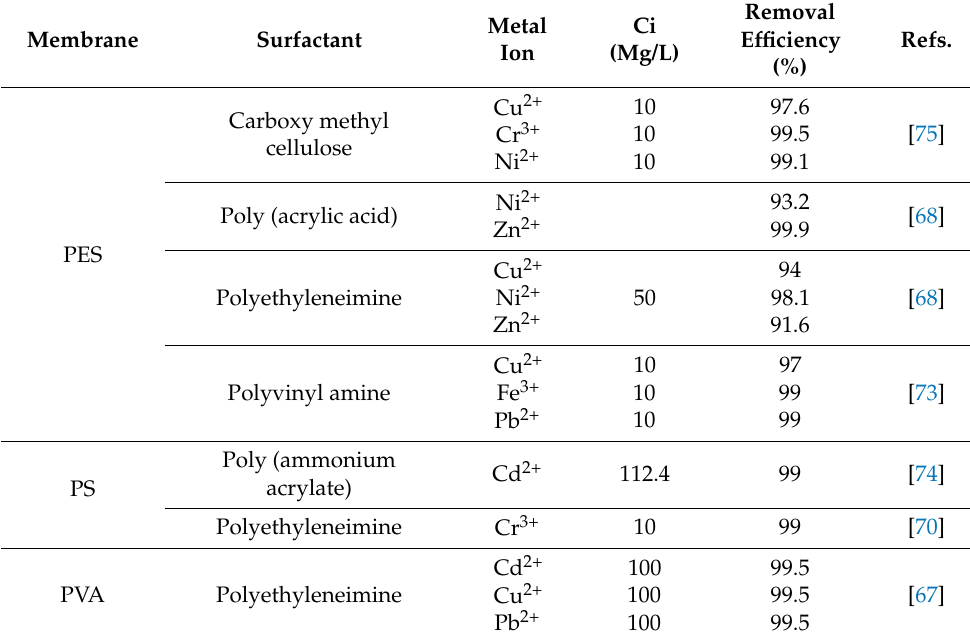
Table 3. Performance of PEUF in heavy metal